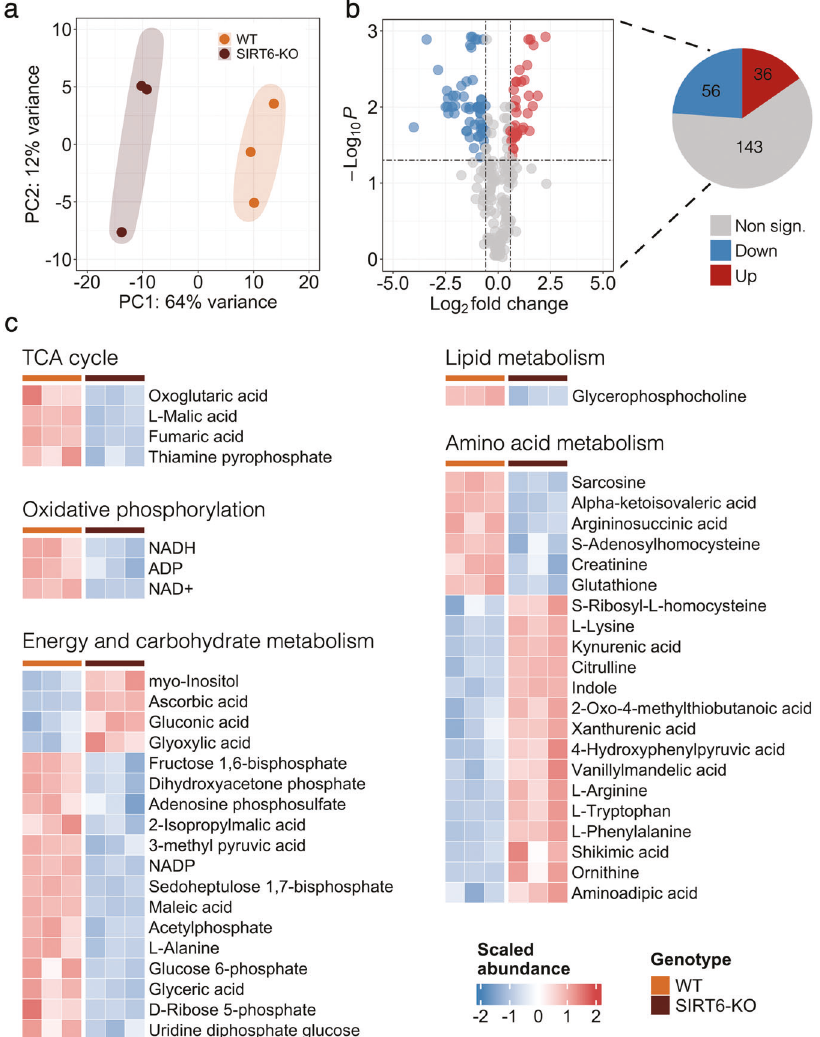
Fig. 2 SIRT6 de fi ciency triggers an abundance of energy metabolites. a PCA plot showing separation between the WT (orange circles) and SIRT6-KO (brown circles) groups based on the mESC metabolomic pro fi les. Orange and brown ovals represent con fi dence ellipses of WT and SIRT6-KO groups. b The volcano plot illustrating differentially abundant metabolites detected between WT and SIRT6-KO mESC samples. Up- and downregulated metabolites are represented by red and blue circles, respectively. The pie plot (on the right) demonstrates the number of upregulated (red), downregulated (blue), and insigni fi cant (gray) metabolites in the analysis. c The abundance heatmap of 68 out of 92 signi fi cant metabolites classi fi ed according to the metabolic pathways they are involved